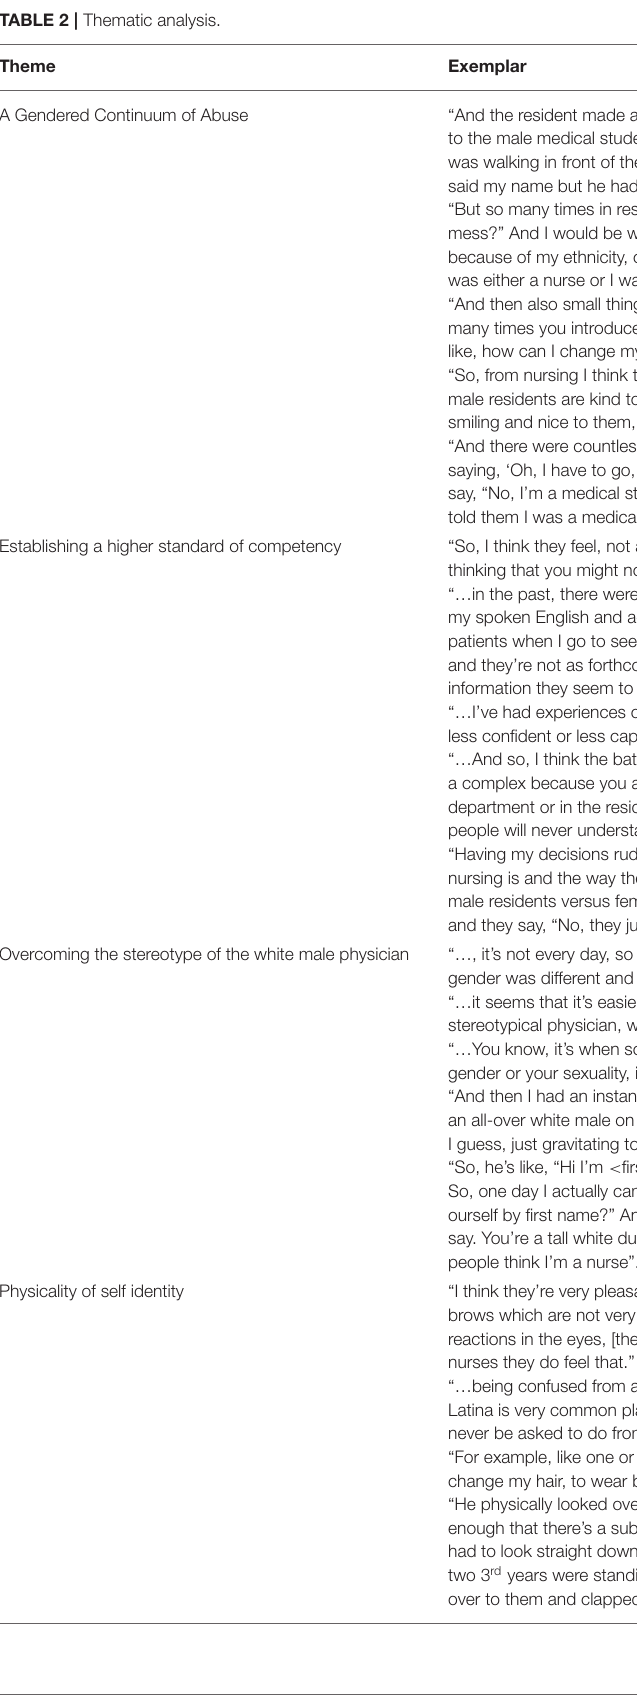
TABLE 2 | Thematic